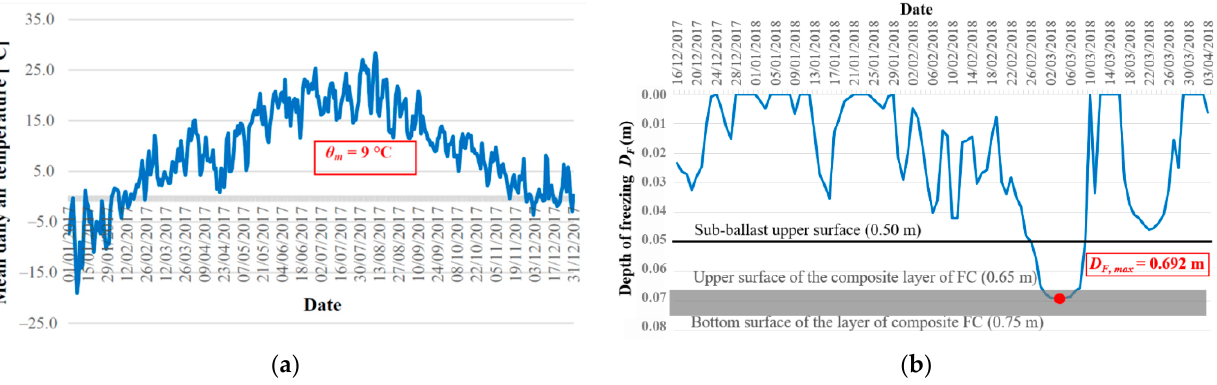
Figure 6. Graphical representation and method of evaluation of climate characteristics of the winter period 2017/2018—average annual air temperature θ m ( a ); freezing depth of the structure D F ( b ).